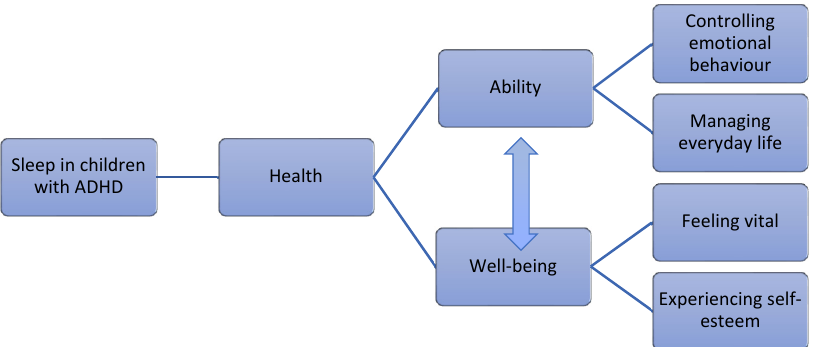
Figure 1. The results describe parents’ experiences of direct and indirect implications of sleep quality on the health of children with ADHD. This figure is based on Tengland’s [26] two-dimensional theory of health, where ability and well-being form the two main categories, followed by four sub- categories.